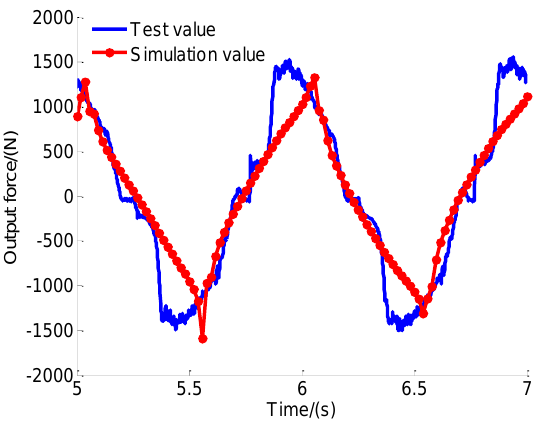
Figure 5. Comparison of simulation and experimental results of output force.